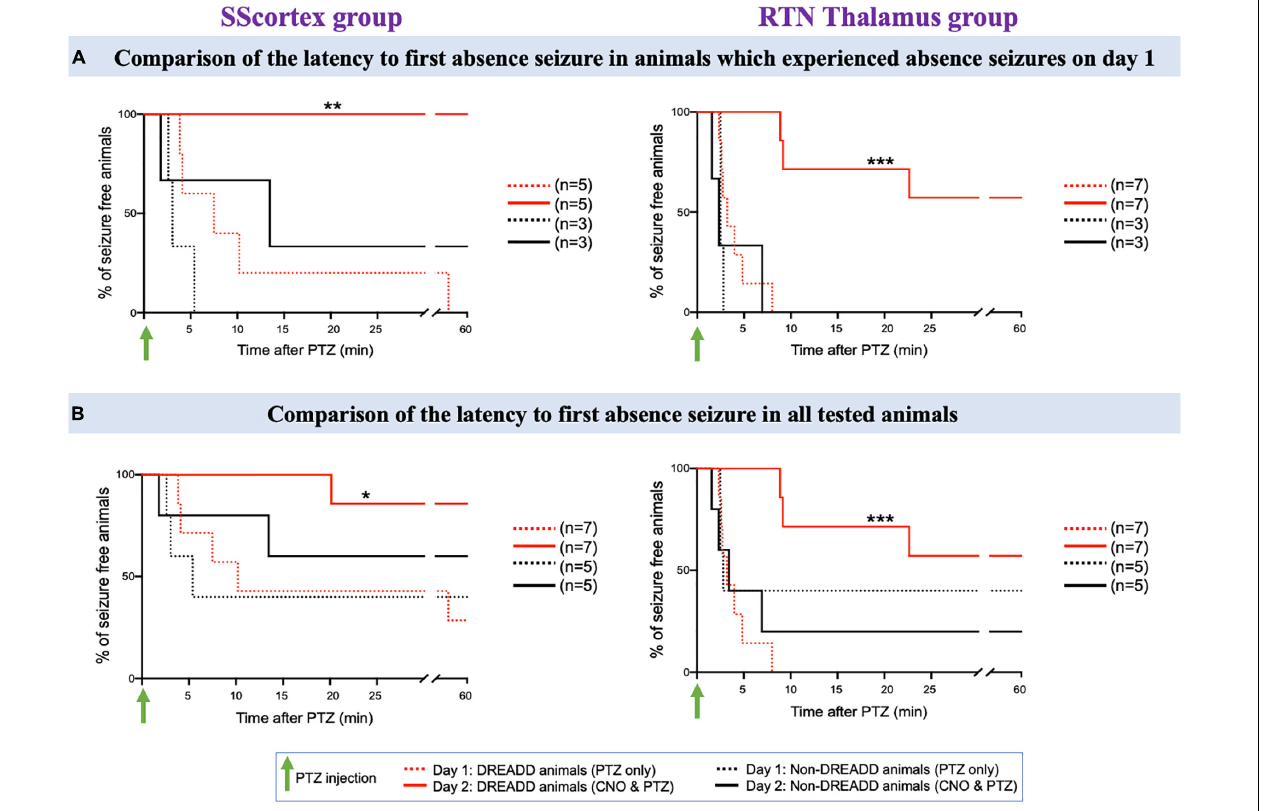
Frontiers in Cellular Neuroscience |